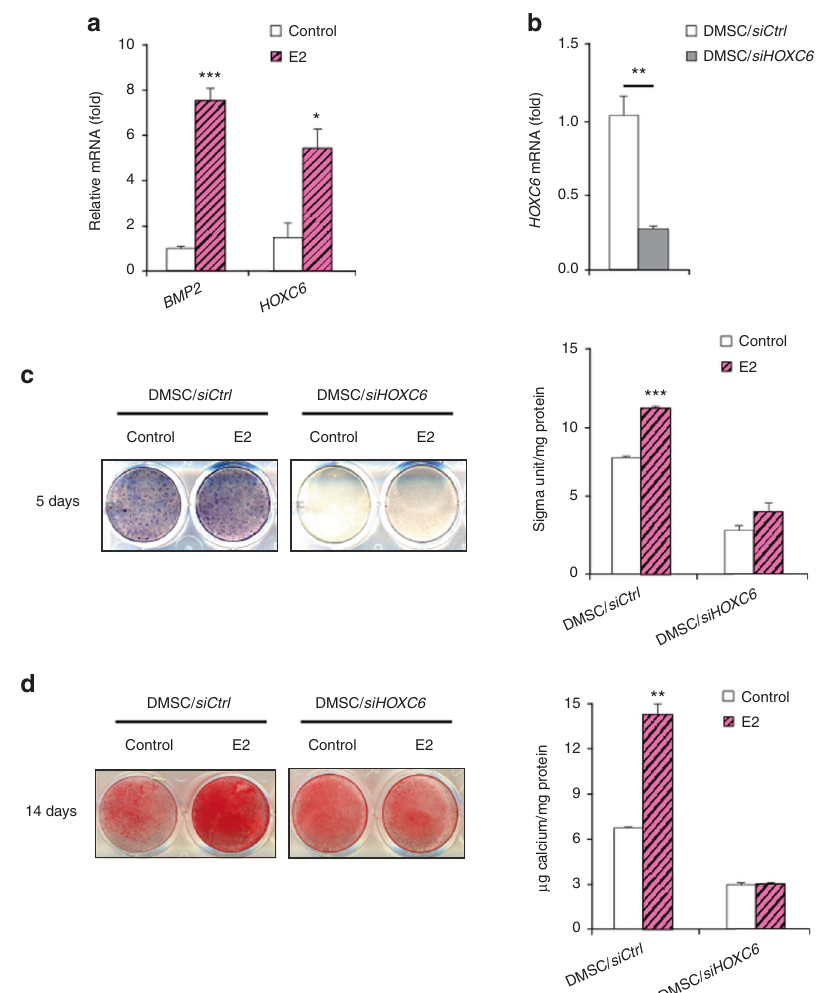
Fig. 3 E2-induced BMP and HOXC6 expression in DMSCs. a qRT-PCR of BMP2 and HOXC6 at 4 h upon E2 treatment in DMSCs. b Depletion of HOXC6 in DMSCs via siRNA by qRT-PCR. c Alkaline phosphatase staining and quanti fi cation of HOXC6-depleted DMSCs after 5 days of treatment in osteogenic media with and without E2. d Alizarin Red S staining and quanti fi cation of HOXC6-depleted DMSCs after 14 days of treatment in osteogenic media with and without E2. Data are presented as the mean ± SEM ( n = 3). For a , data are shown as fold expression of target genes after normalization to the control. For b , data are shown as fold expression of target genes after normalization to DMSC/ siCtrl . For a and b , two groups were compared by two-tailed t -tests. For c and d , all groups were compared by two-way ANOVA with a Bonferroni post hoc test. Asterisks were assigned to P values with statistical signi fi cance (* P < 0.05; ** P < 0.01; *** P <